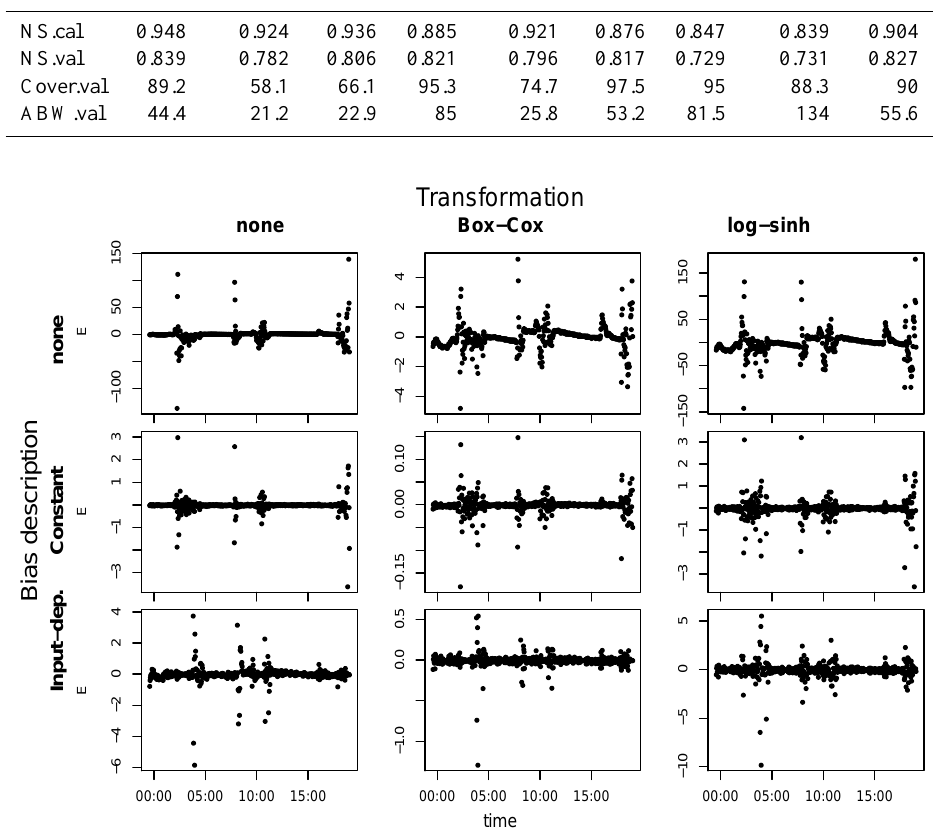
Fig. 5. Time series of median of E , the part of residuals assumed to come from random observation errors. The range illustrated is the same part of the calibration period as shown in Fig. 4. The ordinate axis is in transformed flow units.